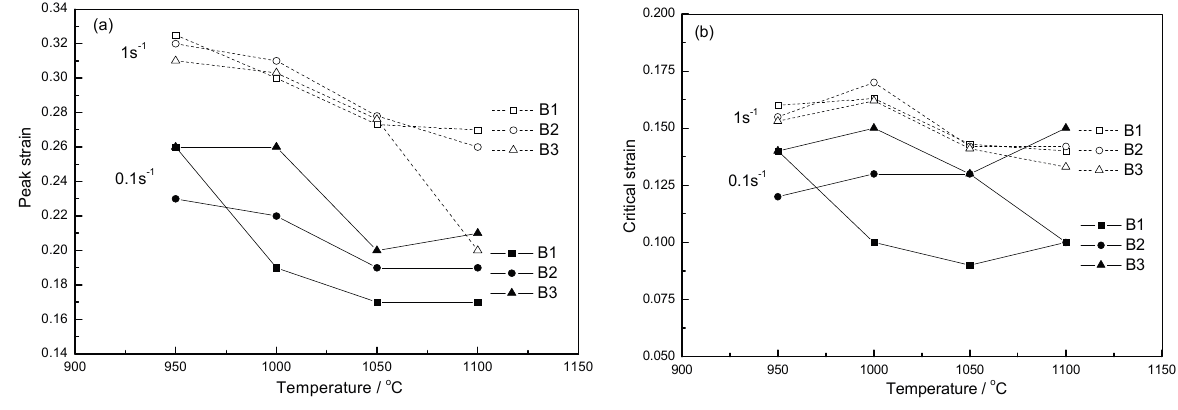
Figure 14. Peak and critical strain versus temperature at 0.1 and 1 s − 1